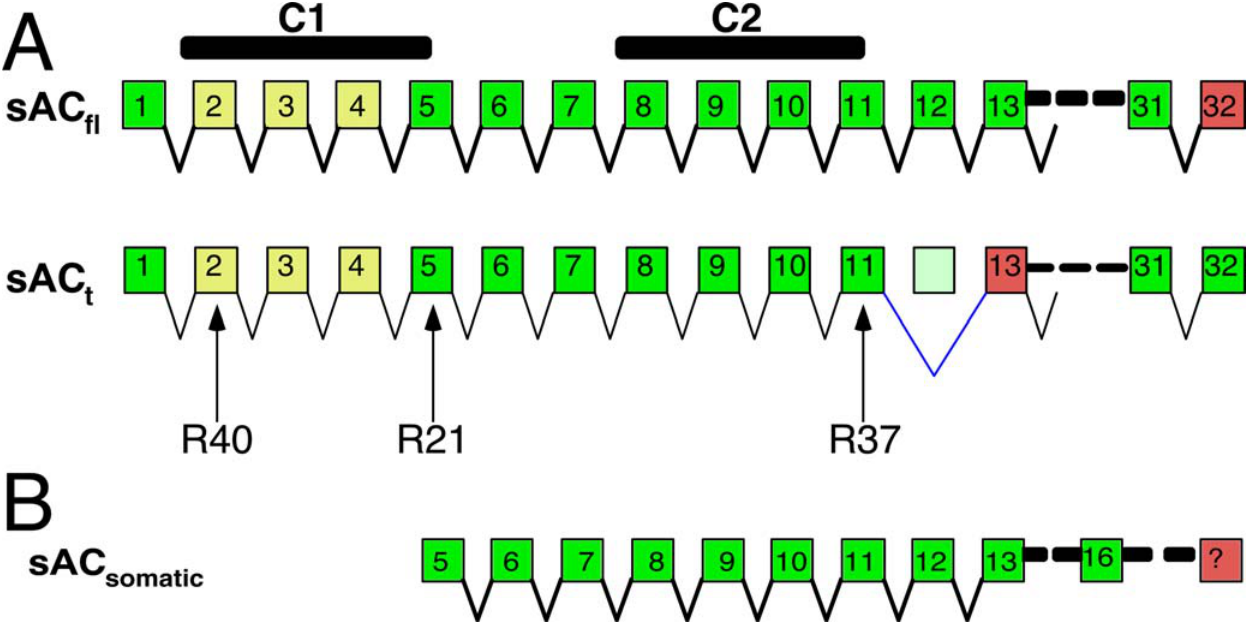
Figure 1. Schematic organization of (A) previously identified, testicular sAC transcripts and (B) the newly identified somatic sAC transcript. Boxes denote exons. C1 and C2 refer to the two catalytic domains. Red exons contain stop codons. (A) sAC fl is encoded by all known coding exons (32), and sAC t is generated by skipping exon 12. Yellow exons (2-4) are removed in the Sacy tm1Lex allele. Arrows indicate approximate locations of epitopes for the indicated monoclonal antibodies (R40, R21, and R37). (B) Somatic sAC transcripts derive from a unique start site upstream of exon 5 and continue through at least exon 16 to an unknown stop.